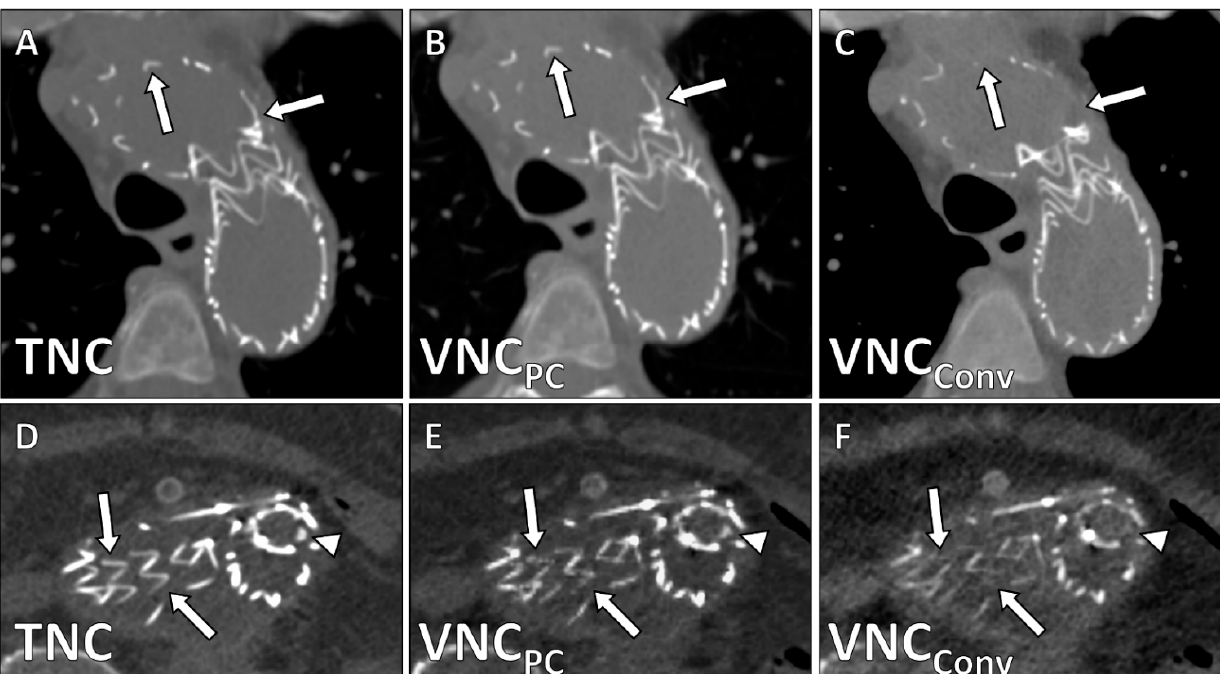
Figure 1. Representative PCD-CT images of a 72-year-old male patient after thoracic EVAR ( A – D ) and a 67-year-old male patient after abdominal EVAR ( E – H ). Unlike in VNC Conv -series, in VNC PC -series only tiny parts of stents (4.7 ± 0.7 vs. 3.8 ±